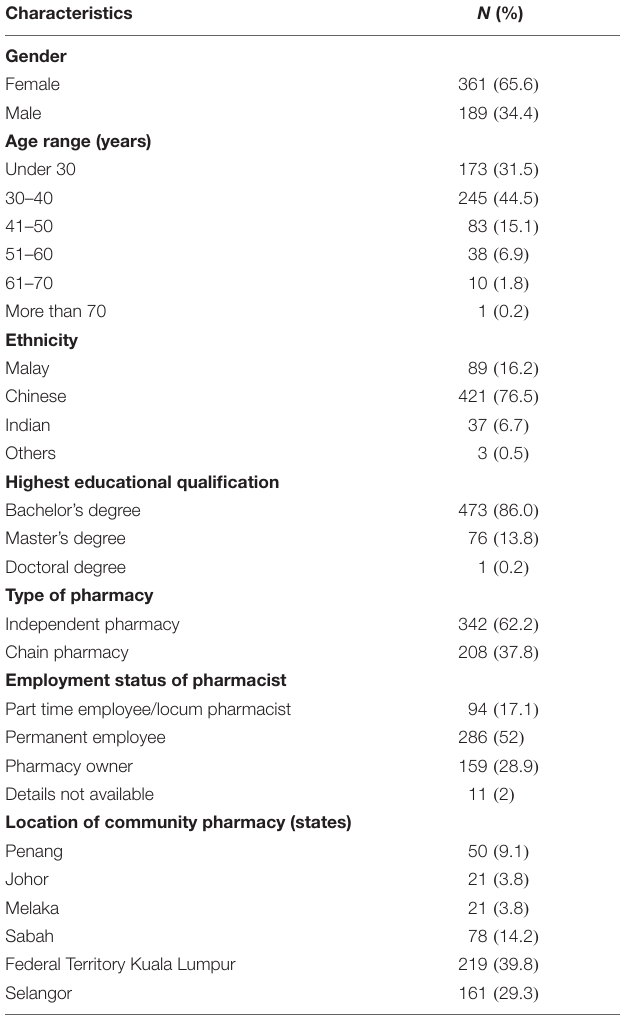
TABLE 1 | Sociodemographic and practice characteristics of the respondents.